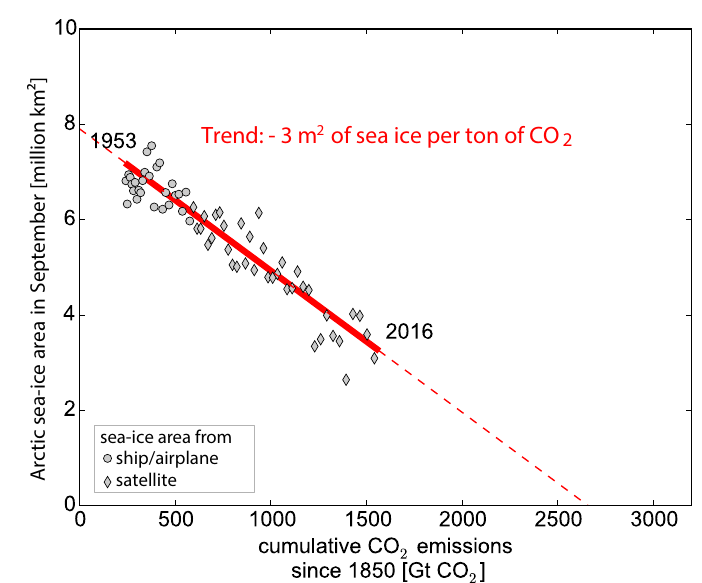
Fig. 4. – Relationship between anthropogenic CO 2 emissions and Arctic sea-ice area in